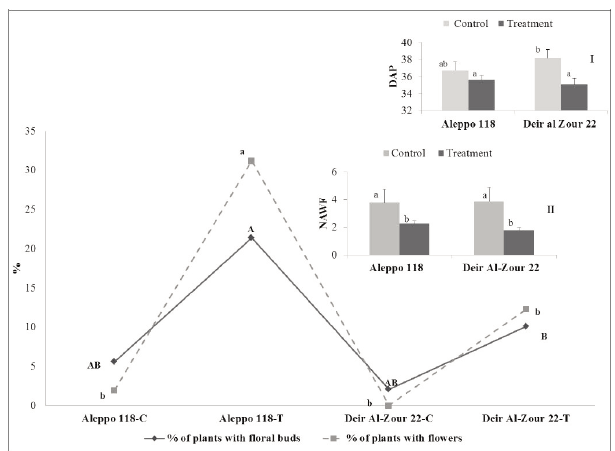
Fig. 2 - The inset graph-I shows floral buds emergence in days after planting (DAP) in control and treated ‘Aleppo 118’ and ‘Deir Al-Zour 22’ plants. The inset graph-II repre- sents NAWF counts in control and treated plants of both cultivars. Data were subjected to Duncan’s test with a confidence level of 95% using STATISTICA program. Columns sharing a letter are not significantly different. Data represent means and standard error of three repli- cations. The Original graph is the percentages of plants with flowers and plants with floral buds of both control and treated Aleppo 118 and Deir Al-Zour 22 cultivars, five months after planting. Data were subjected to Duncan’s test with a confidence level of 95% using STA- TISTICA program. Line markers sharing a letter are not significantly different (capital letters for plants with floral buds and small letters for plants with